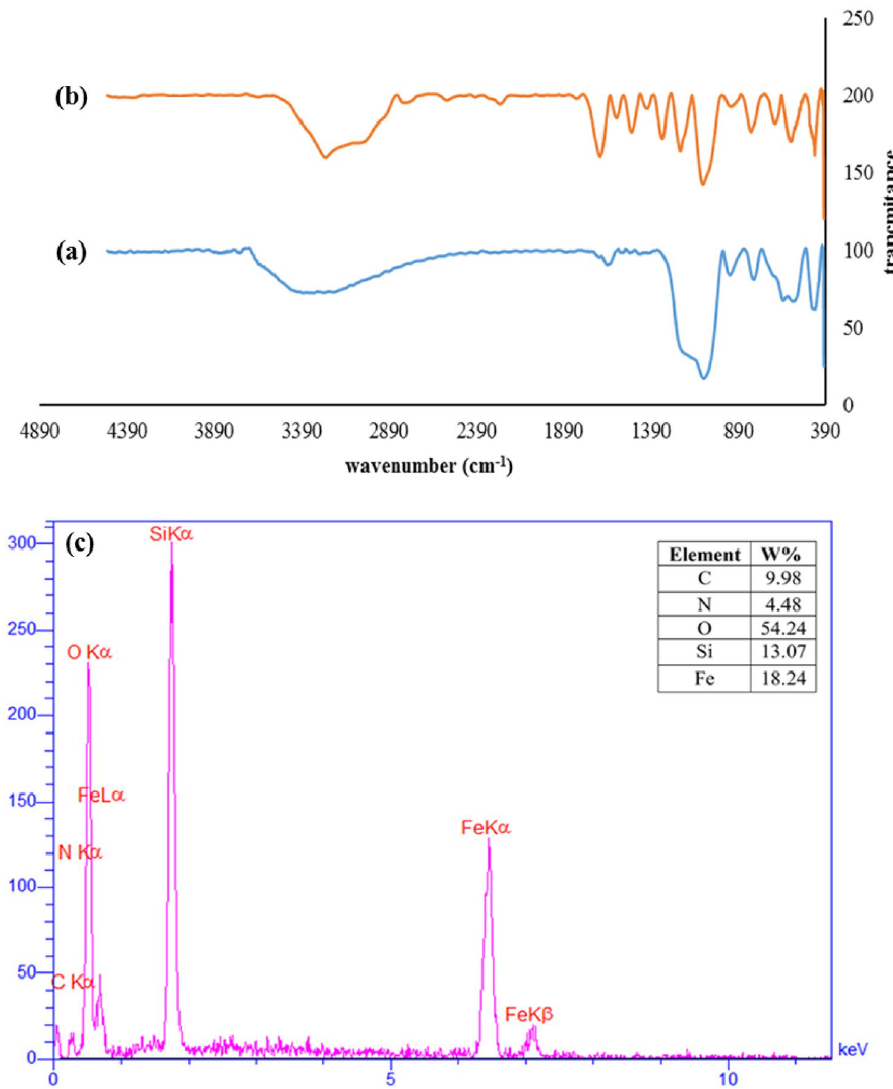
Figure 2. FT-IR spectra of ( a ) chloropropylated Fe 3 O 4 @SiO 2 MNP, ( b ) Fe 3 O 4 @SiO 2 -creatine nanobiocomposite and ( c ) EDX analysis of Fe 3 O 4 @SiO 2 -creatine